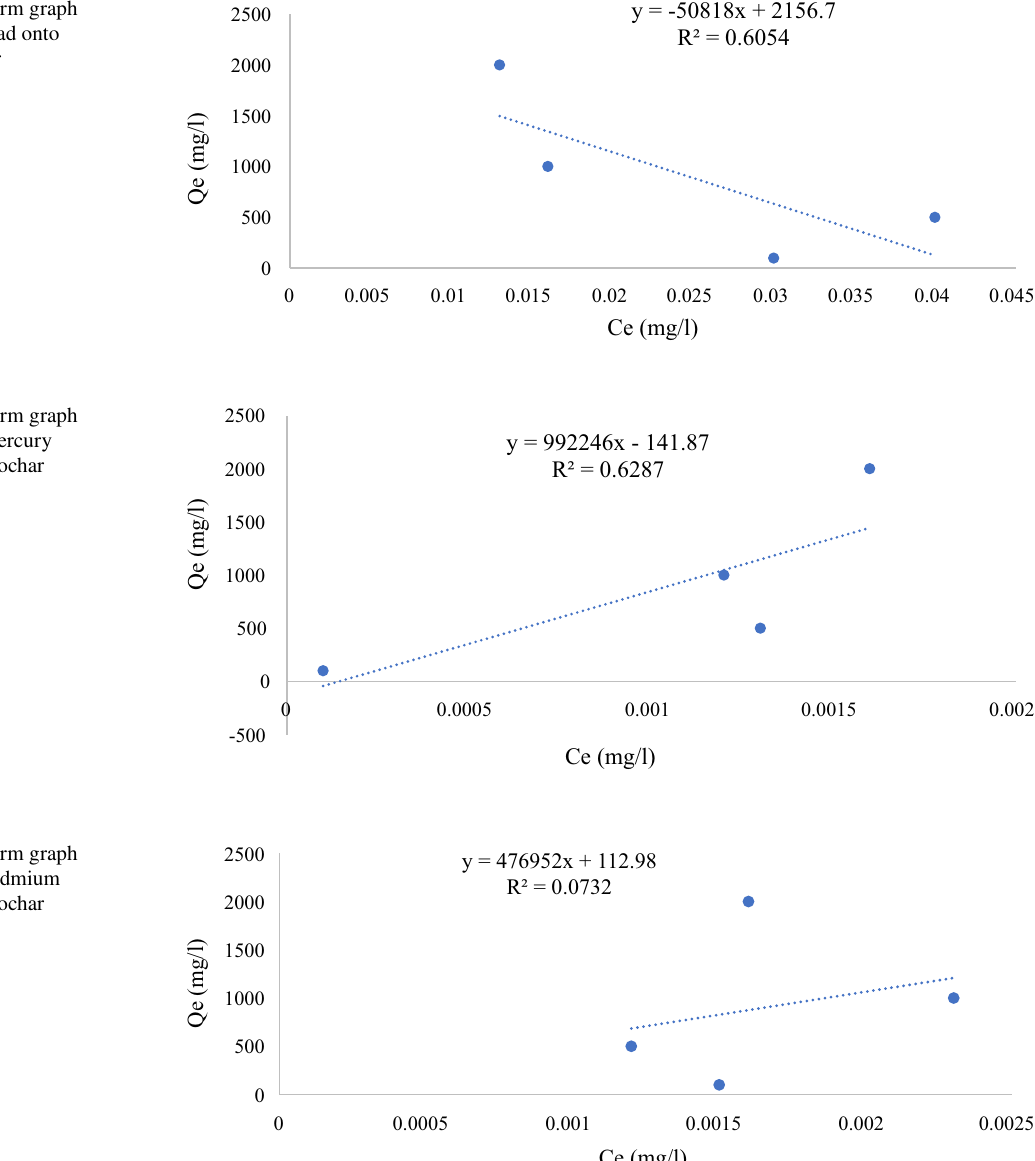
Fig. 3 Langmuir isotherm graph for the adsorption of cadmium onto cacao pod husk